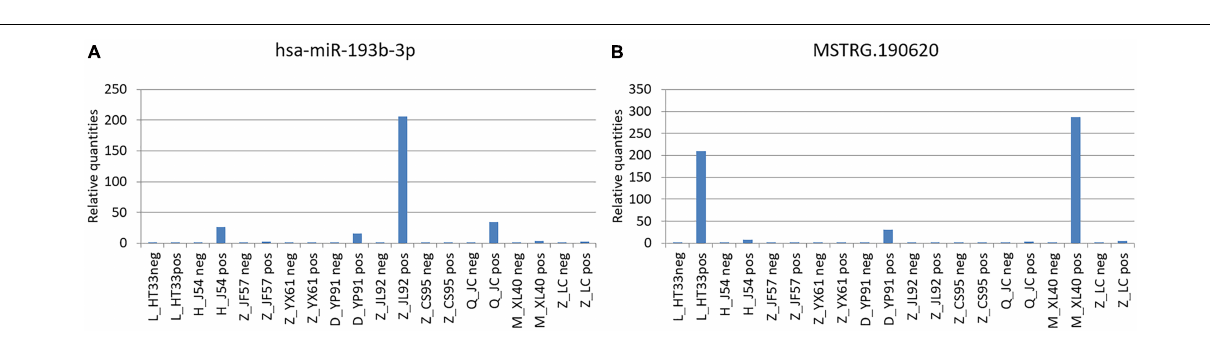
FIGURE 13 | Verification of novel lncRNAs: According to the original detection results of RT-PCR, and the relative quantities calculated by 2 − (cid:77)(cid:77) ct, the difference of the transcription level of target gene of each sample was calculated. The ordinate is the relative expression of novel lncRNA in MM. (A) MSTRG.155519 performed by qPCR; (B) MSTRG.13132 performed by qPCR.